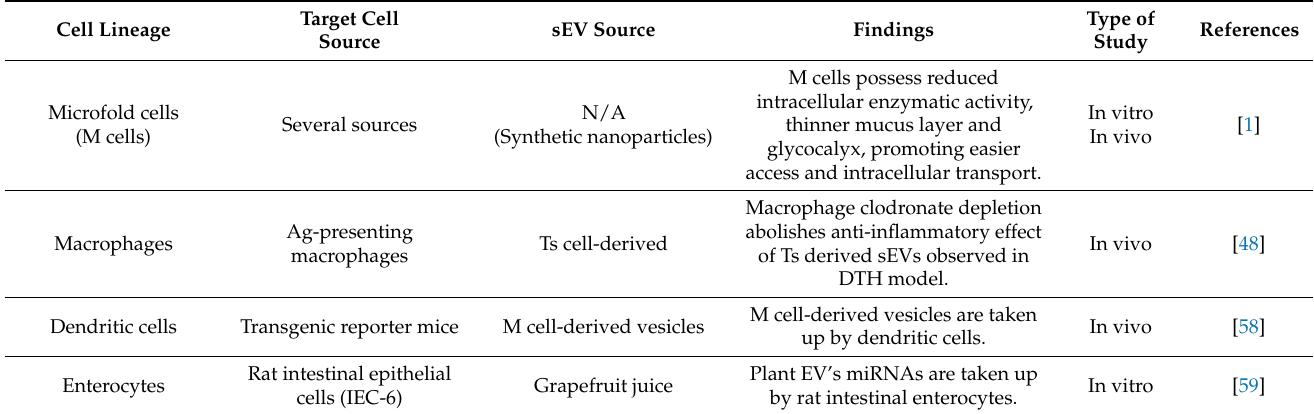
Table 4. Summary of cellular and molecular mediators of sEVs uptake in oral